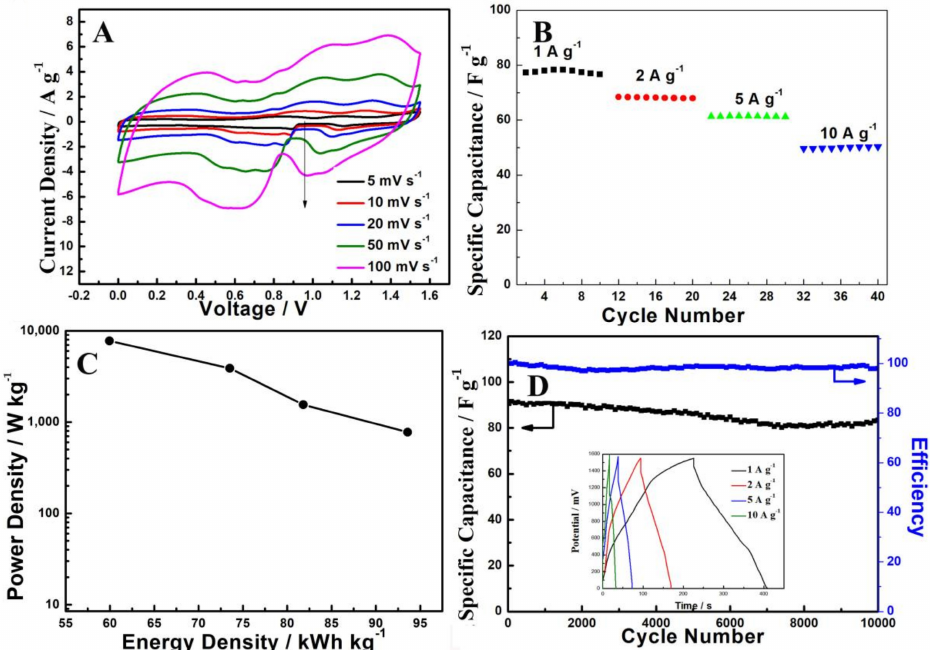
Figure 7. ( A ) CV curves of Mn-Ag-0.10//rGO at various scan rates (5–100 mV s − 1 ); ( B ) Rate performance of Ag-0.10//rGO; ( C ) Ragone plot of the energy density and the power density of Mn-Ag-0.10//rGO; ( D ) Cycling stability and coulombic efficiency of Mn-Ag-0.10//rGO. The insert is the galvanostatic charge-discharge curves tested at 1 A g − 1 .